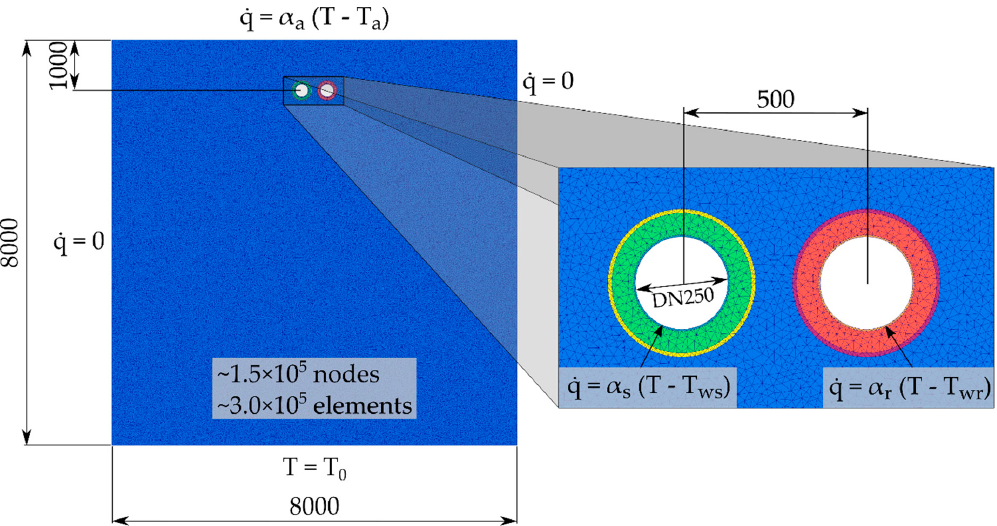
Figure 1. Domain, mesh, and boundary conditions of the complex model, where q ̇ is applied boundary heat flux, α are constant coefficients of heat transfer ( α s = 600 W·K − 1 ·m − 2 , α r = 600 W·K − 1 ·m − 2 , heat flux, α are constant coe ffi cients of heat transfer ( α s = 600 W · K − 1 · m − 2 , α r = 600 W · K − 1 · m − 2 , α a α a = 20 W·K − 1 ·m − 2 ), T is the domain temperature, T 0 is a constant temperature of the Dirichlet boundary